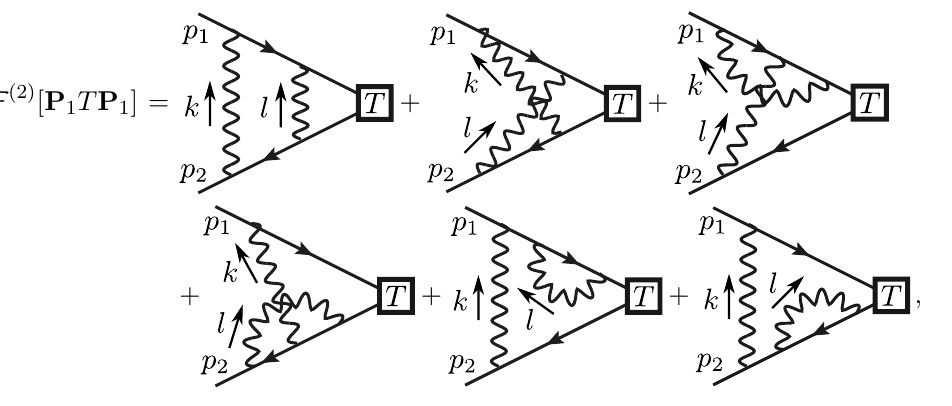
Figure 1. Diagrams that contribute to F (2) for arbitrary order in the local vertex T